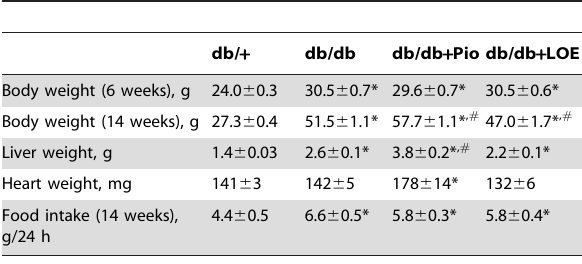
Table 1. Effect of LOE and pioglitazone on body weight, organ weight and food intake in db/db